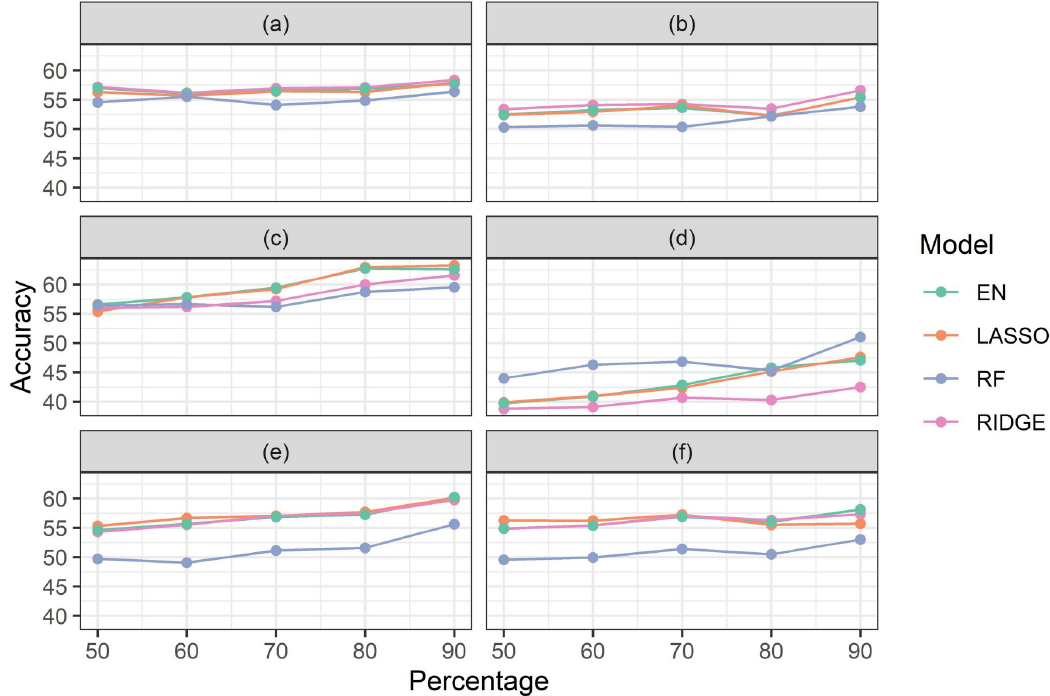
Fig 3. Accuracies generated by different models with different regressions from training data optimization test. The X-axes show “Percentage” of data used as training data and the Y-axes show the corresponding accuracies. For each model results from elastic net (EN), lasso (Lasso), ridge (Ridge), and random forest (RF) have been shown. The models tested were for–(a) time series CHM for vegetative growth stage, (b) time series CHM for reproductive stage, (c) S VI-SUMs for vegetative growth stage, (d) S VI-SUMs for reproductive stage, (e) S VI-AUCs for growth stage, and (f) S VI-AUCs for reproductive stage.